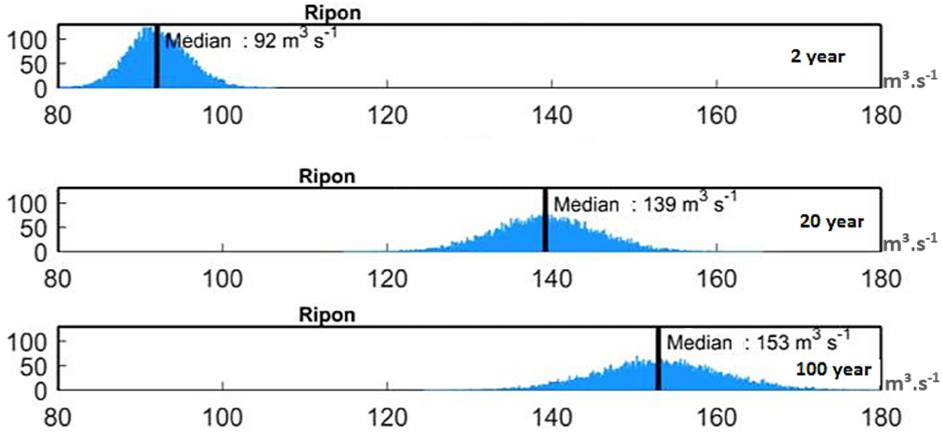
Figure 5. Annual flow distribution for different return periods (2, 20, and 100 years) at Station 040406.